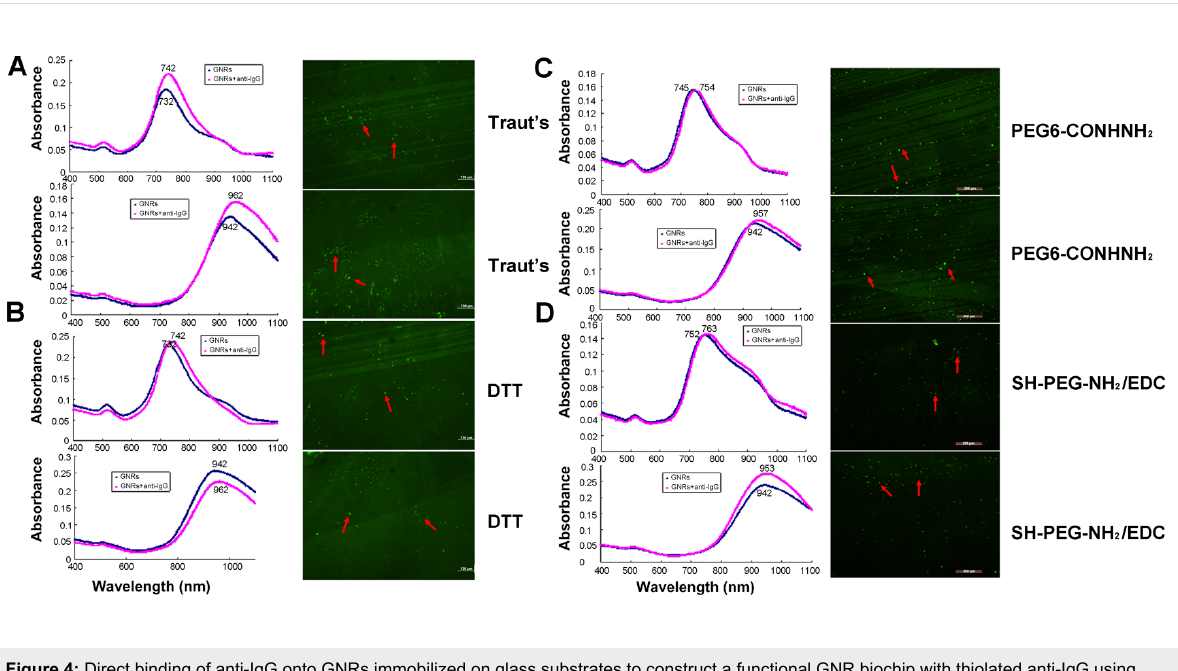
Figure 4: Direct binding of anti-IgG onto GNRs immobilized on glass substrates to construct a functional GNR biochip with thiolated anti-IgG using (A) Traut’s reagent, (B) DTT, (C) PEG6-CONHNH 2 , and (D) SH-PEG-NH 2 combined with EDC reaction. Left: absorption spectra of GNRs with 728 and 930 nm longitudinal plasmonic bands. Right: fluorescence microscopy of the GNR biochip functionalized with thiolated anti-IgG.